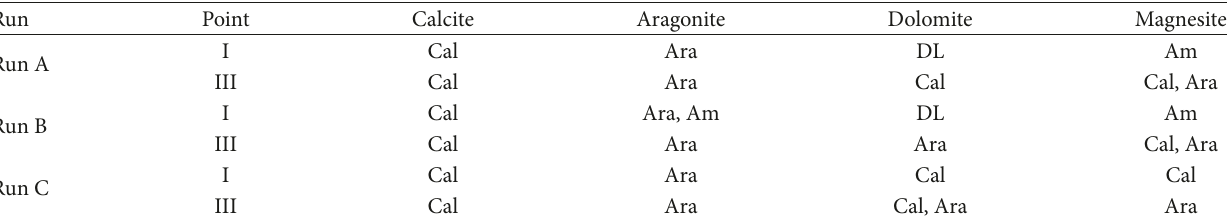
Table 3: Formation phase on each seed